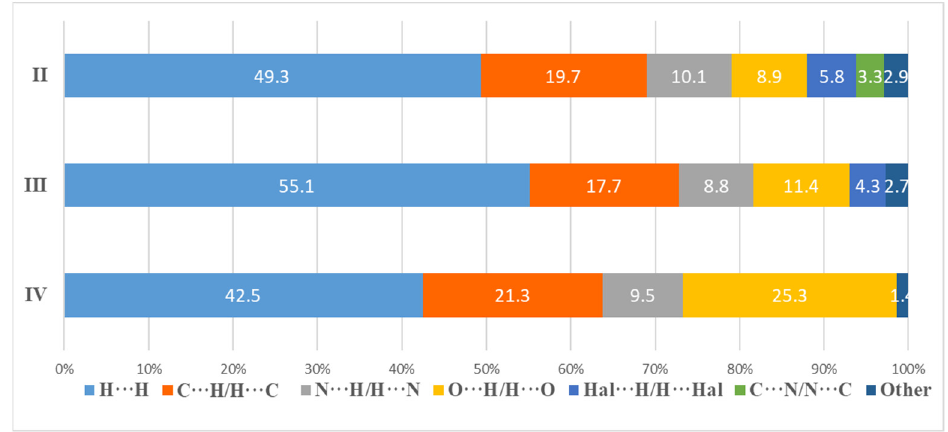
Figure 9. Percentage contributions to the Hirshfeld surface area for the various close intermolecular contacts for II – IV .